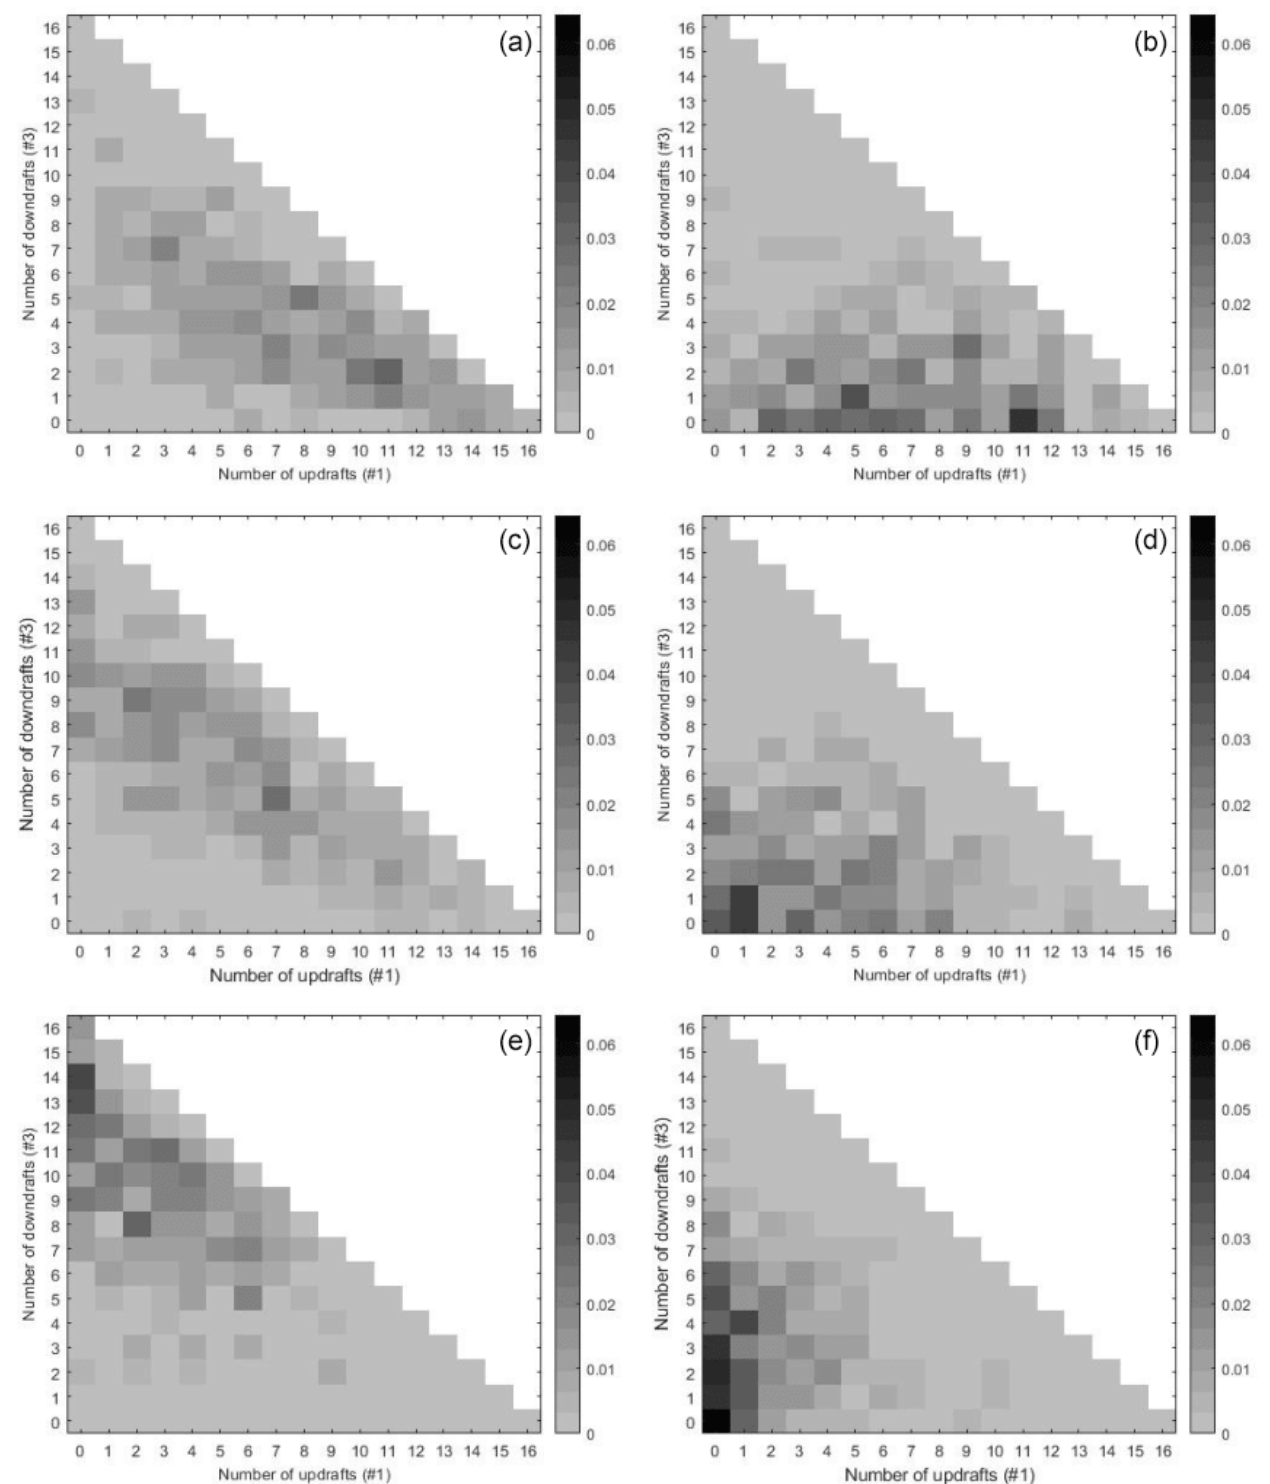
Figure A2. Histograms show probabilities of numbers of updrafts (#1) and downdrafts (#3) conditioned on high (a, b) , median (c, d) , and low (e, f) latent states. Panels (a) , (c) , and (e) present day data and panels (b) , (d) , and (f) the night data. CAPE and vertical velocity data correspond to the data applied in Fig.